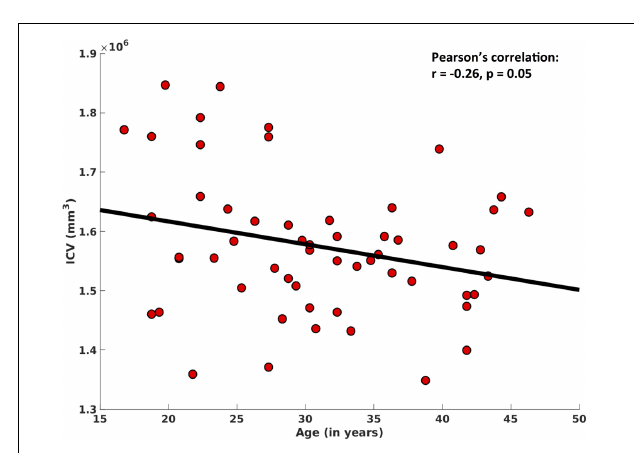
FIGURE 5 | Correlation between intracranial volume (ICV) and age. After regressing out the effect of ‘gender,’ here we show a significant negative association between ICV and